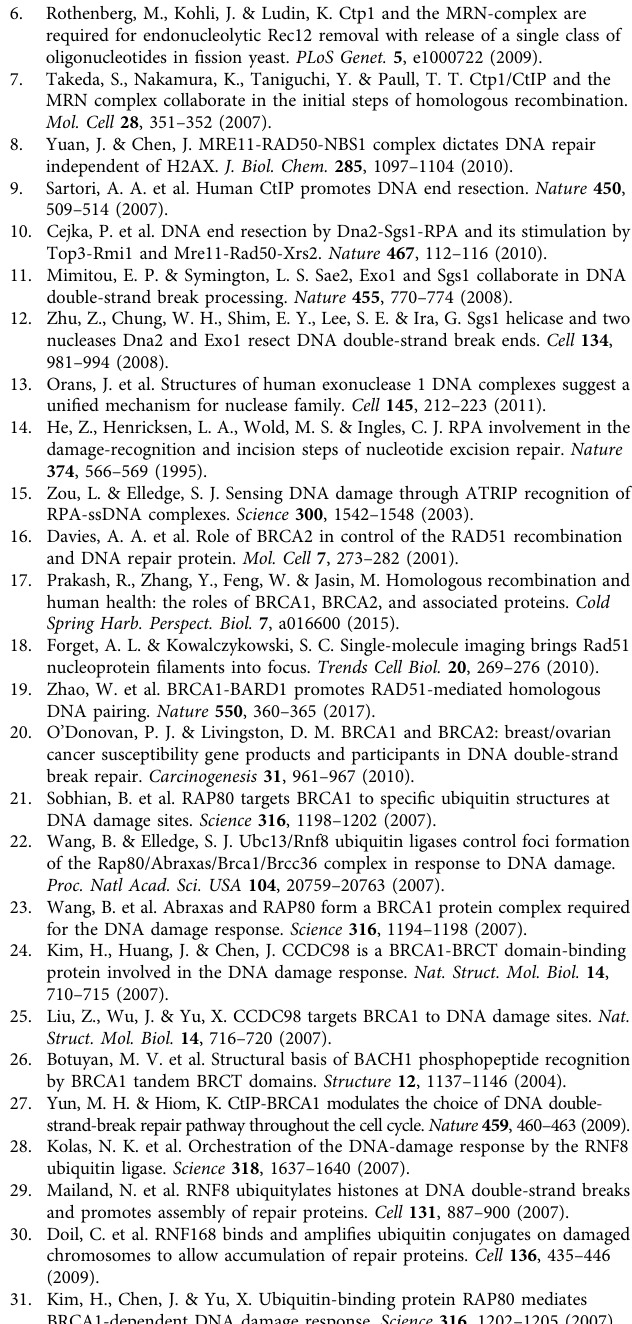
Fig. 7 The cancer-associated USP15 mutation resulted in homologous recombination (HR) defect. a A schematic representation of breast cancer- associated USP15 mutations. b USP15-knockout U2OS direct repeat green fl uorescent protein (DR-GFP) cells were reconstituted with HA-USP15 wild-type (WT) or deletion mutant (DM) and HR ef fi ciency were determined. Data are presented as mean±SD of three independent experiments. Student's t